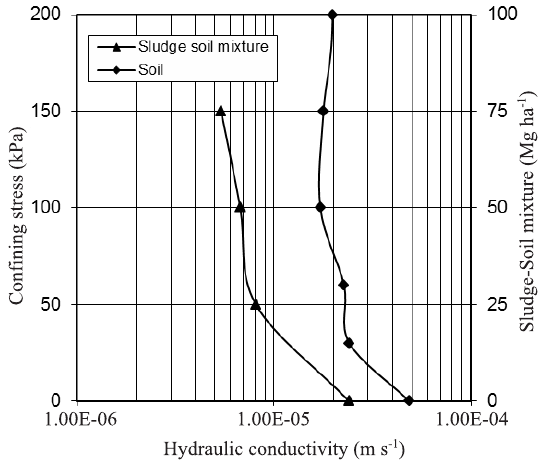
Figure 6. Hydraulic conductivity of soil and sludge- soil mixtures.